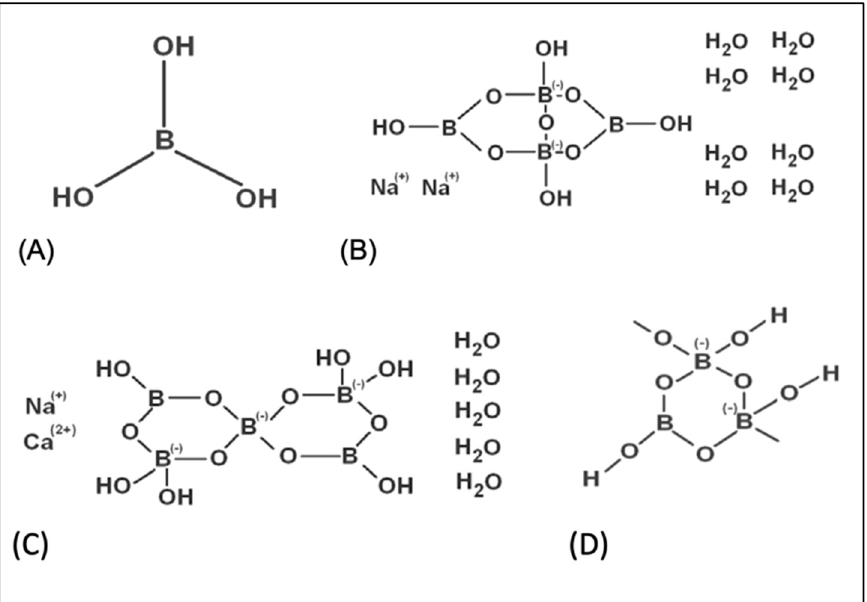
Figure 1. The chemical structures of tested boron compounds. ( A ) boric acid, ( B ) borax, ( C ) ulexite, ( D ) colemanite.